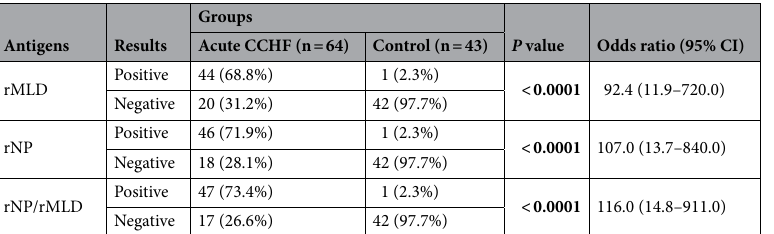
Table 1. Comparison of test results for the Rec-ELISA using rNP, rMLD, and rNP/rMLD probed with sera of acute phase CCHF patients (n: 64). CI confidence interval. Bold values are statistically significant for P <0.05.